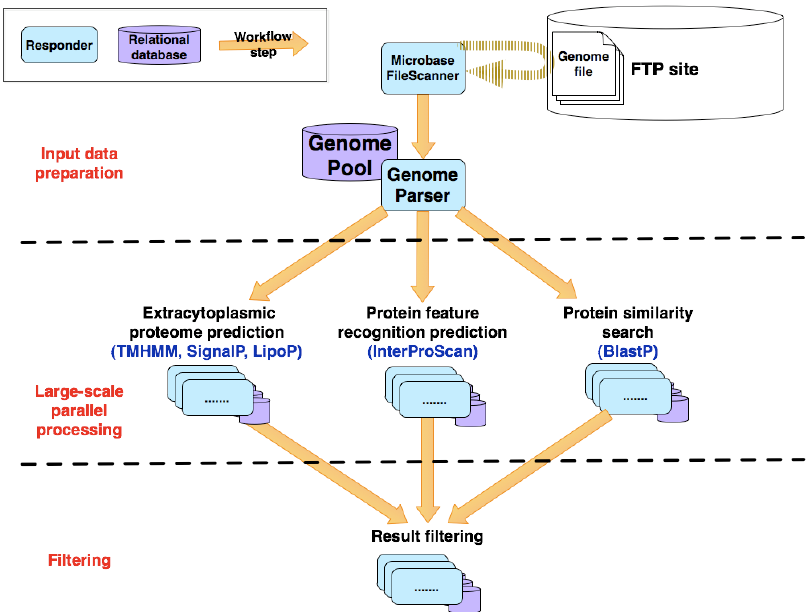
Figure 2: The EPPP workflow consists of multiple Microbase2.0 responders. The workflow starts with events generated by the FileScanner responder, which is configured to periodically scan an FTP server for new files. The GenomeParser responder reacts to the presence of new genome files by parsing and storing them in a structured database, the GenomePool. Once a new genome has been stored notification messages are sent to analysis responders, resulting in a large amount of computational work being scheduled. Each responder has its own independent database. Finally, the results from each analysis tool are extracted and integrated into a relational